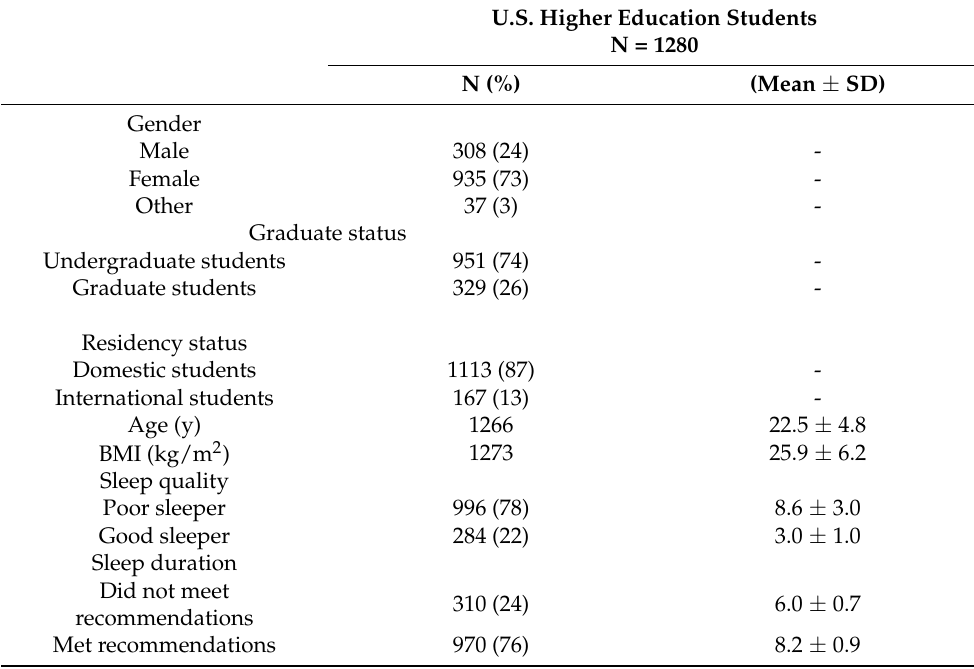
Table 1. Demographic, anthropometric, and sleep